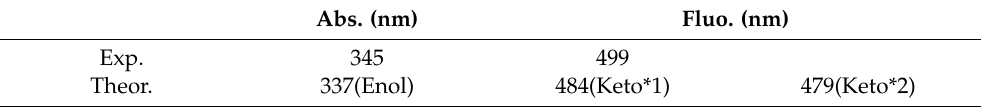
Table 2. The absorption and emission peaks of BP(OH) 2 in hexane solvent. Abs. (nm) Fluo. (nm) Exp. 345 499 Theor. 337(Enol) 484(Keto*1) 479(Keto*2)